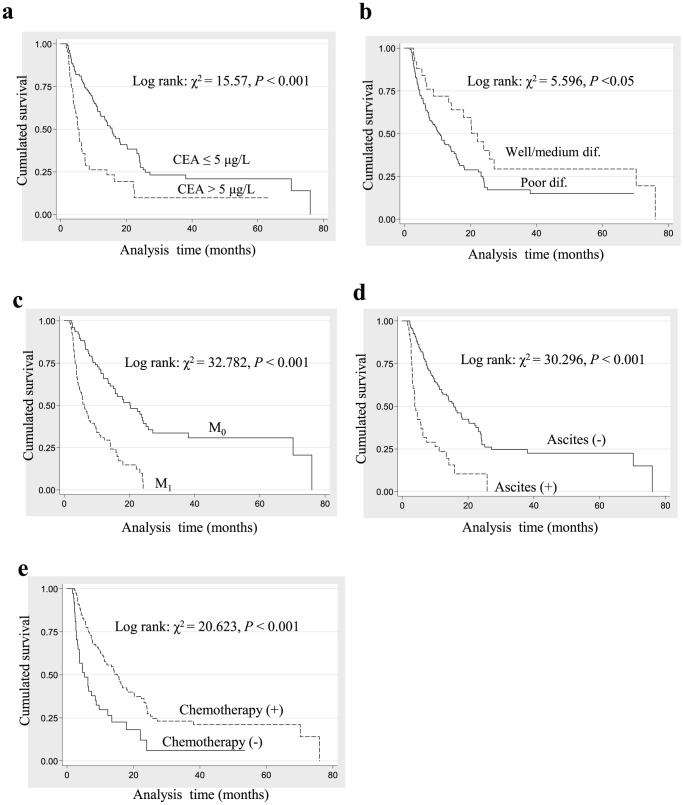
Survival curves for patients with gastric cancer (GC) at the Nanfang Hospital with clinicopathological factors.The figures are labeled as follows: cumulative survival of patients with GC with (a) Carcinoembryonic antigen (CEA)≤5 µg/L or >5 µg/L, (b) different differential (dif.) degree, (c) with (M1) or without (M0) metastasis, (d) with or without ascites, (e) with or without chemotherapy.